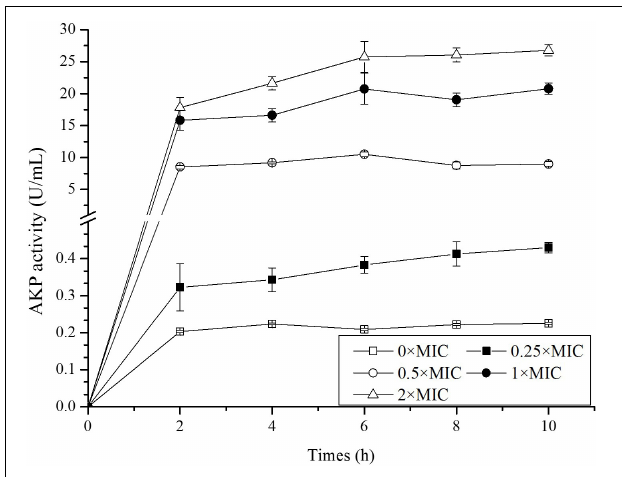
FIGURE 4 | Detection of alkaline phosphatase (AKP) activity in Salmonella exposed to different doses of CGA.